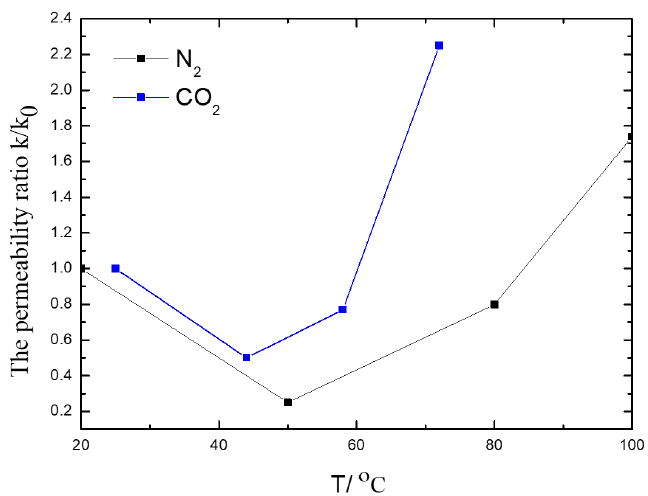
Figure 1. The permeability ratio curve with temperature.